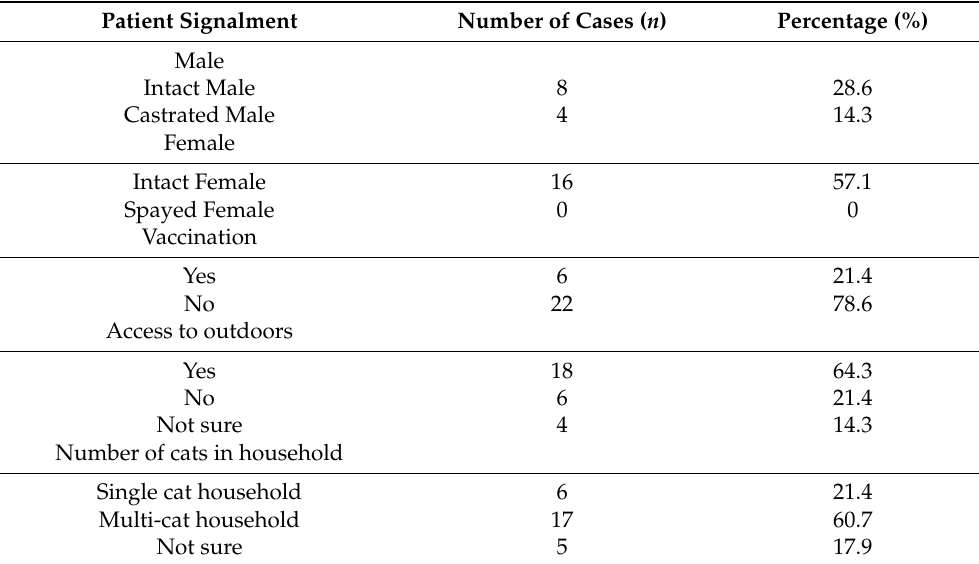
Table 2. Patient signalment of 28 cats with